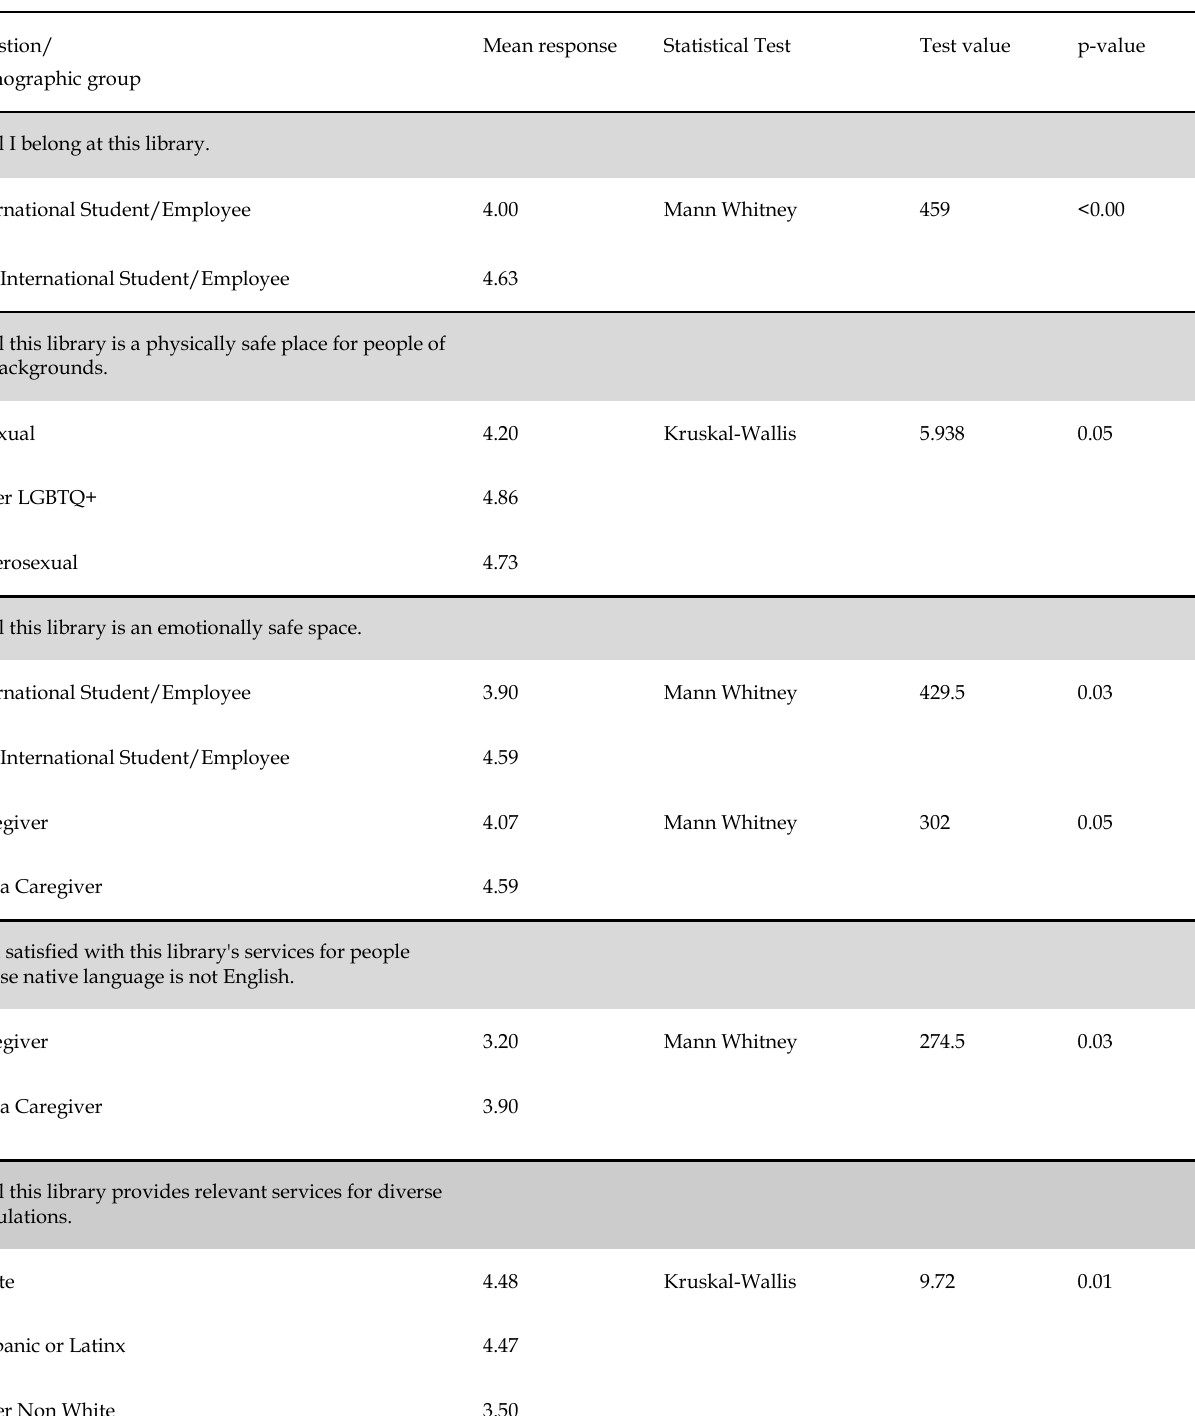
Table 2 Questions which had statistically significantly different responses across one or more demographic